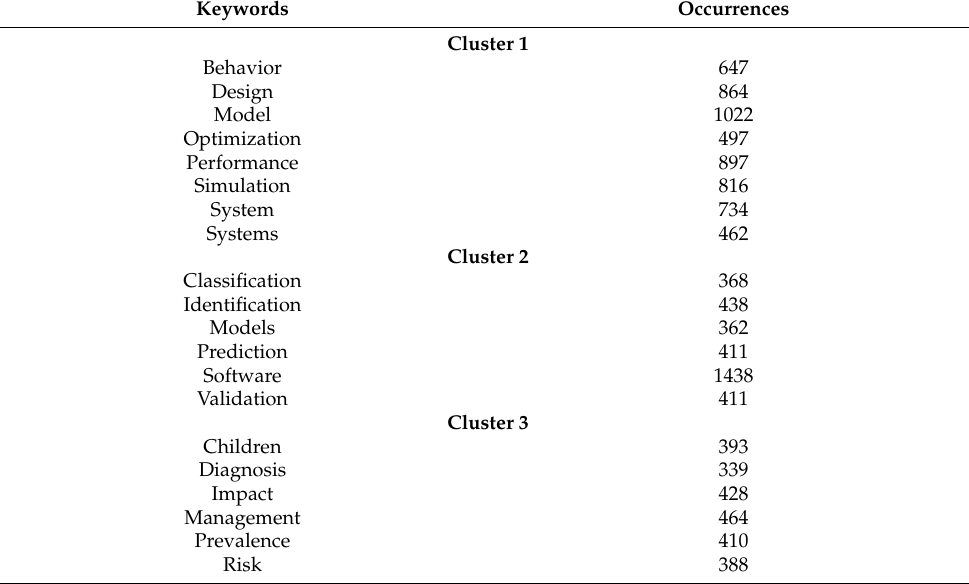
Table 15. Number of occurrences of top 20 Keywords in each cluster for the years (2016–2018).